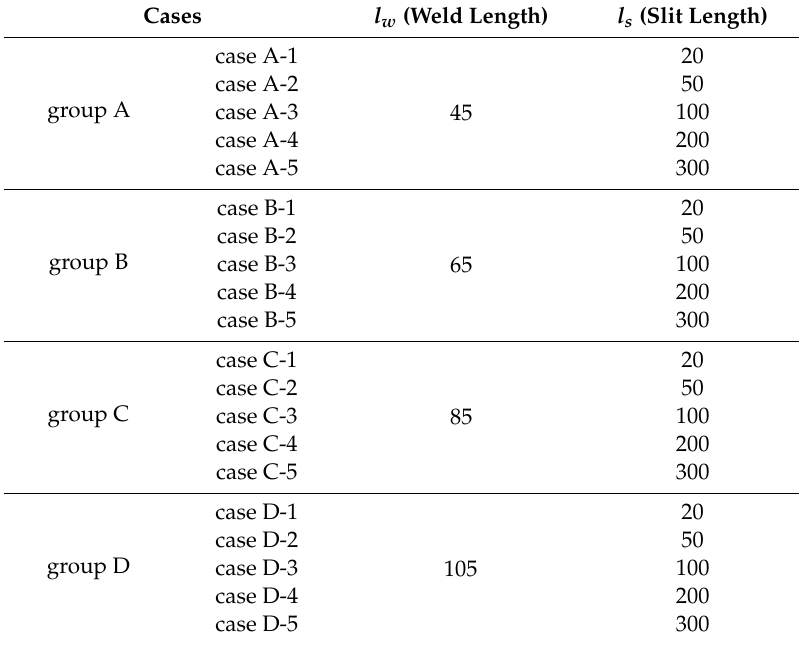
Table 4. Simulation cases with varied weld length ( l w ) and slit length ( l s ).